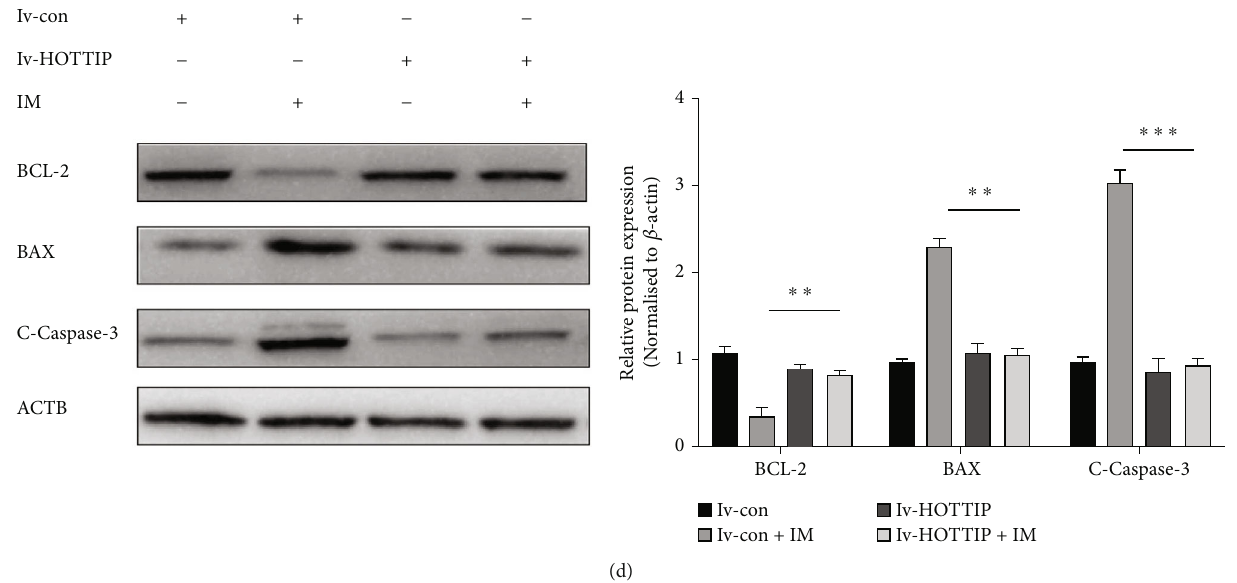
Figure 3: Upregulation of HOTTIP decreases the sensitive of IM in K562 cells. Note: (a) K562 was transfected with speci fi c lv-RNA of HOTTIP or negative lv-RNA (lv-con). RT-qPCR was used to detect HOTTIP level. (b) K562 cells were transfected with speci fi c lv- HOTTIP or negative lv-con and treated with di ff erent Imatinib concentrations for 48h. CCK-8 analysis was used to detect cell inhibition. ∗∗ p < 0 : 05 vs. sh-con. (c) K562 cells were transfected with speci fi c lv-HOTTIP or negative lv-con and treated with Imatinib for 48h. Cell apoptosis was detected by fl ow cytometry using Annexin V/APC/PI. The right panel shows the apoptosis rate from three independent experiments. ∗∗ p < 0 : 01 vs. sh-on. (d) Western blotting for protein levels in K562 cells transfected with lv-HOTTIP or negative lv-con and treated with IM (0.5 μ M) or DMSO for